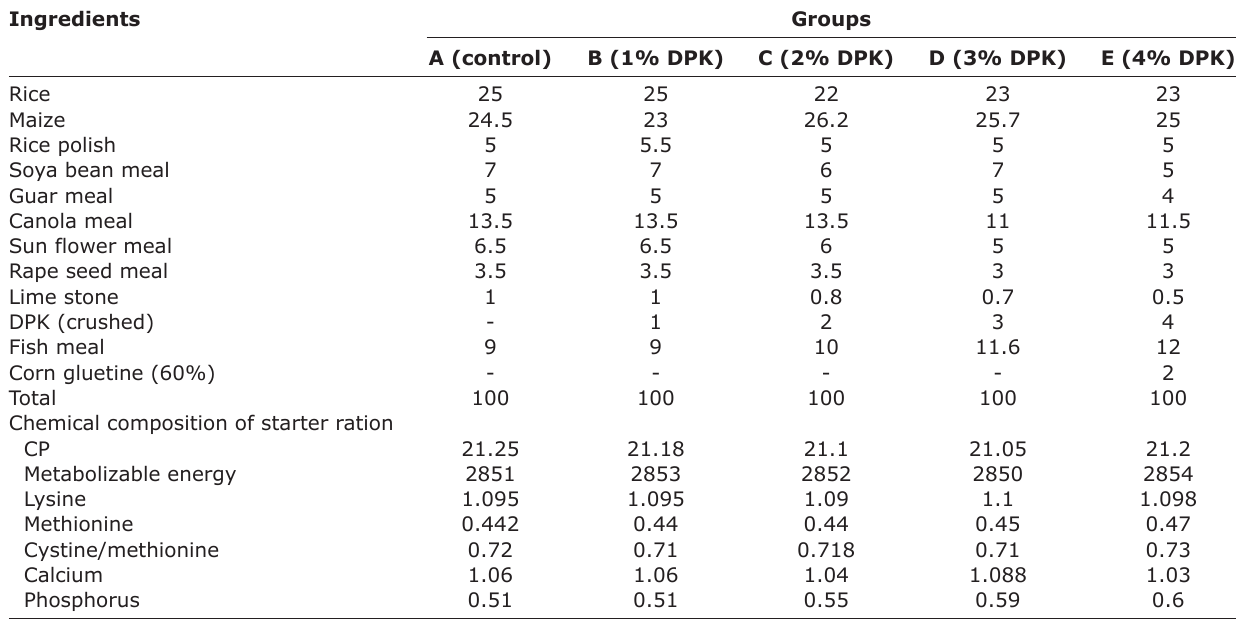
Table-1: Experimental starter ration (%) of broiler chicken included various levels of DPK.